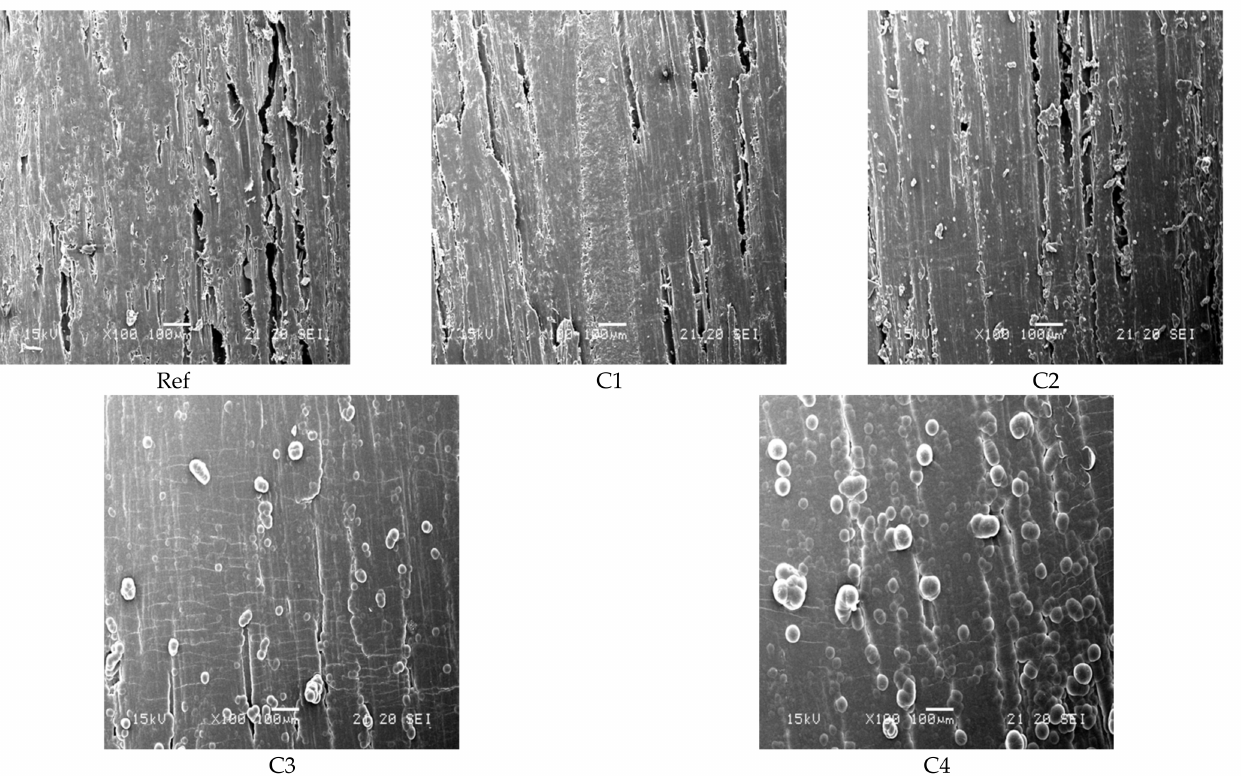
Figure 2. SEM images of the uncoated beech wood ( Ref ) and the parylene-coated ( C1 – C4 ) beech wood (magnification 100 × ).